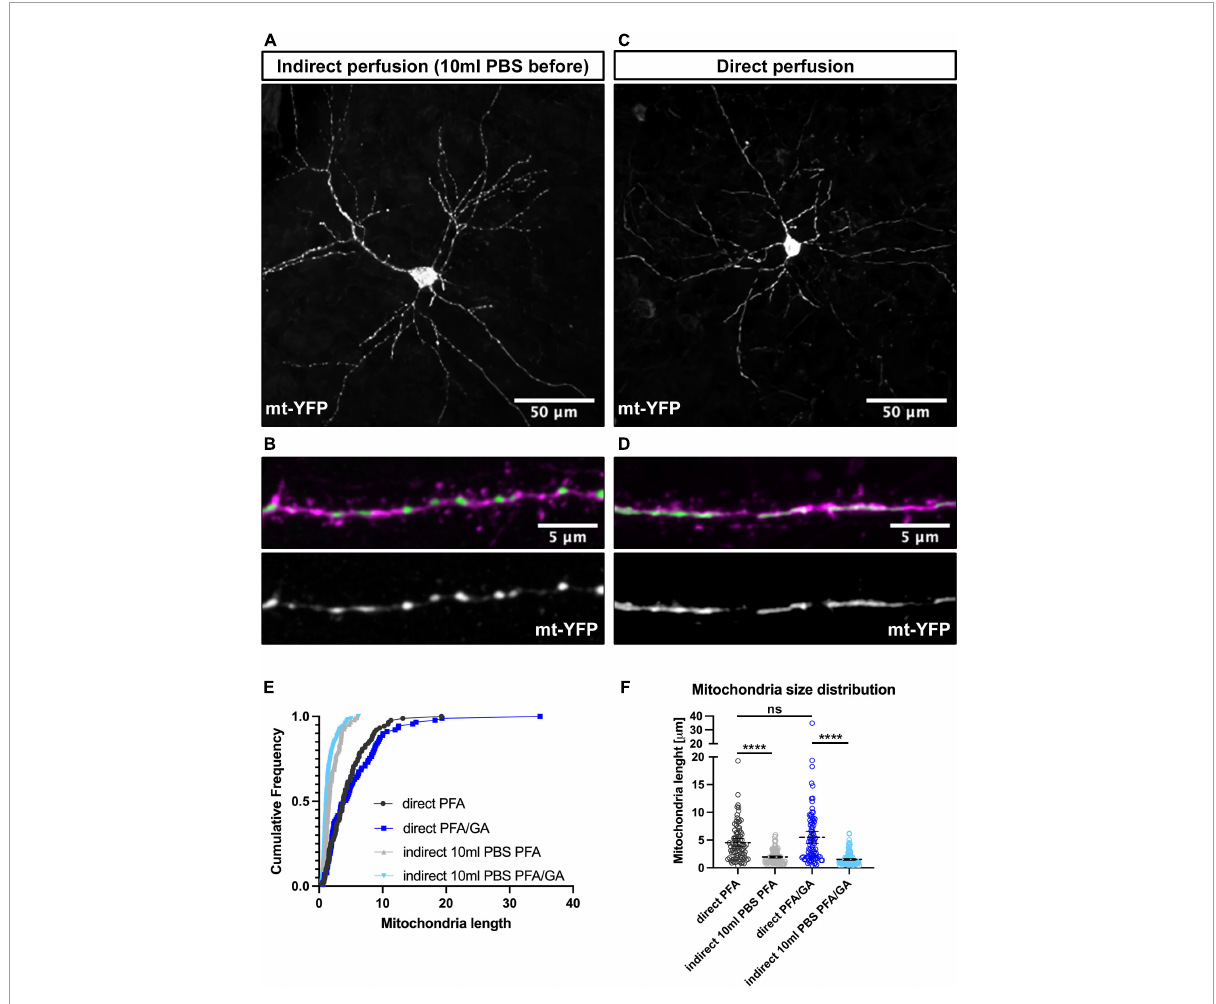
FIGURE2 Direct perfusion is necessary for preserving mitochondrial morphology in vivo . (A) Low magnification representative neuron following indirect perfusion with PFA/GA solution. (B) High magnification of a dendrite segment following indirect perfusion with PFA/GA. (C) Low magnification representative neuron following direct perfusion with PFA/GA solution. (D) High magnification of a dendrite segment following direct perfusion with PFA/GA. (E) Cumulative frequencies of dendritic mitochondrial length showing that indirect perfusion results in fragmentation of mitochondria. (F) Quantification of dendritic mitochondrial lengths shown as mean ± 95% CI before and after fixation with the indicated fixative solution. Kruskal–Wallis test with Dunn’s multiple comparisons test. n indirectPFA = 15 dendrites, 150 mitochondria, n directPFA = 11 dendrites,